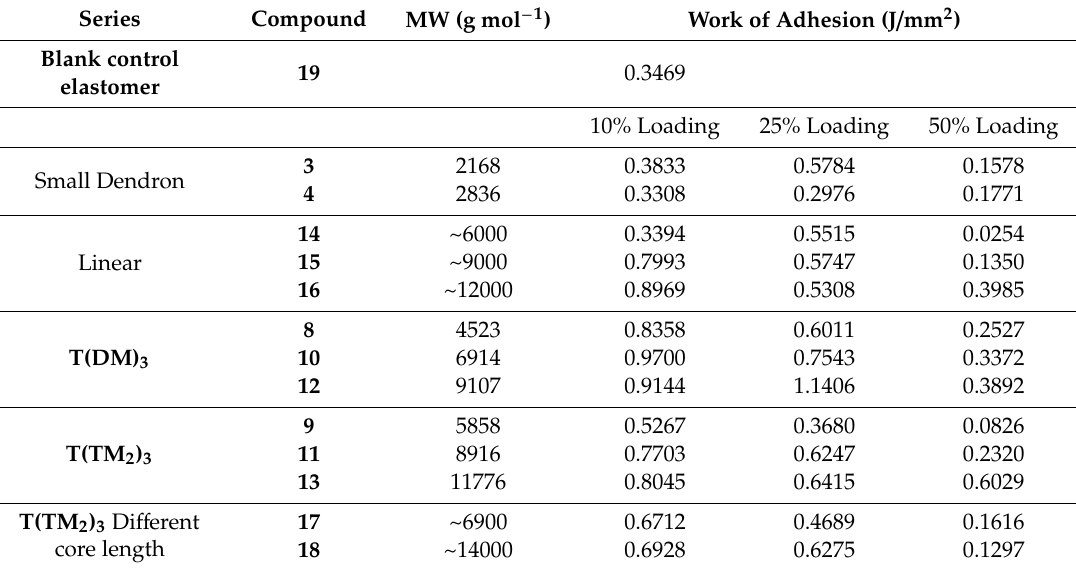
Table 1. Work of adhesion of oil filled